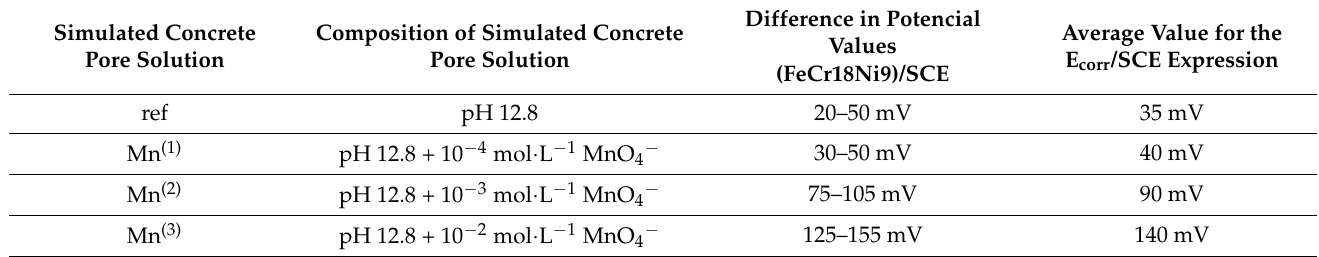
Table 5. Comparison of potentials between a plate of stainless steel (FeCr18Ni9) and SCE for simulated pore solutions of concrete with graded amounts of MnO 4 − anions.